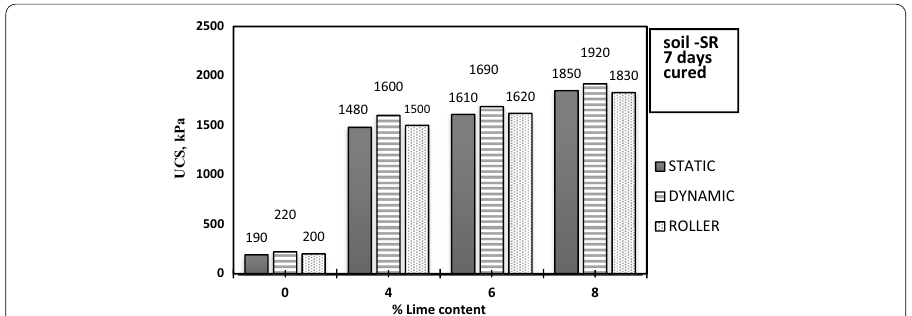
Fig. 9 Effect of lime on UCS of soil SR compacted by different methods of compaction cured for 7 days